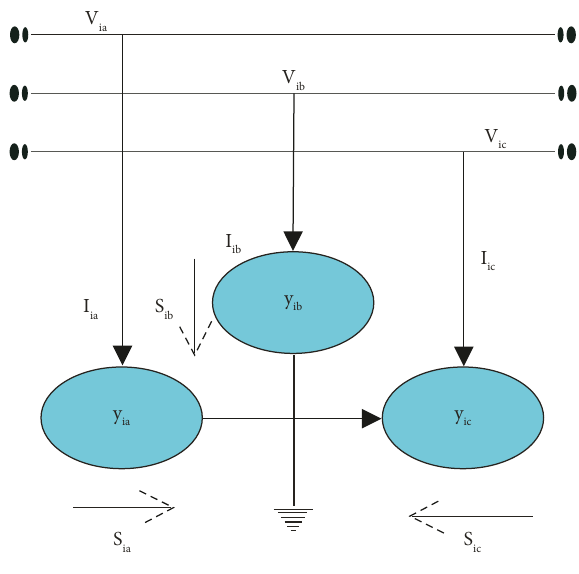
Figure 3: Star load structure